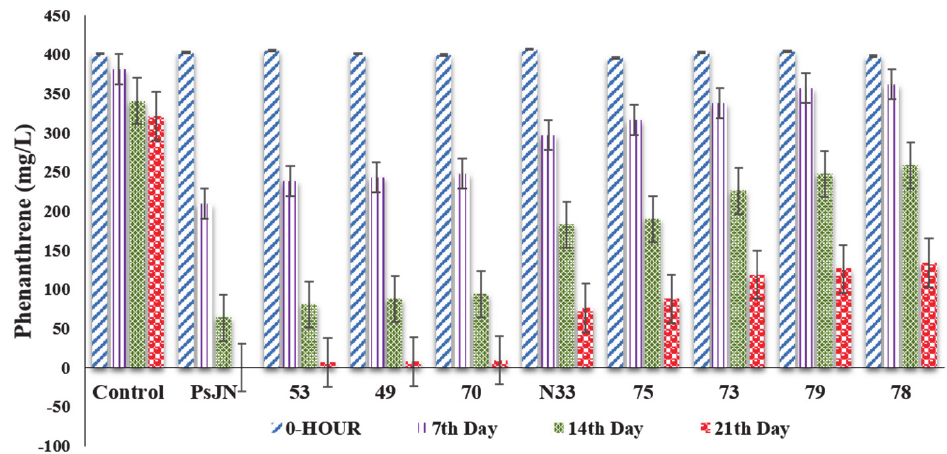
Figure 4. Hydrocarbon (phenanthrene) removal by nine different bacterial strains.